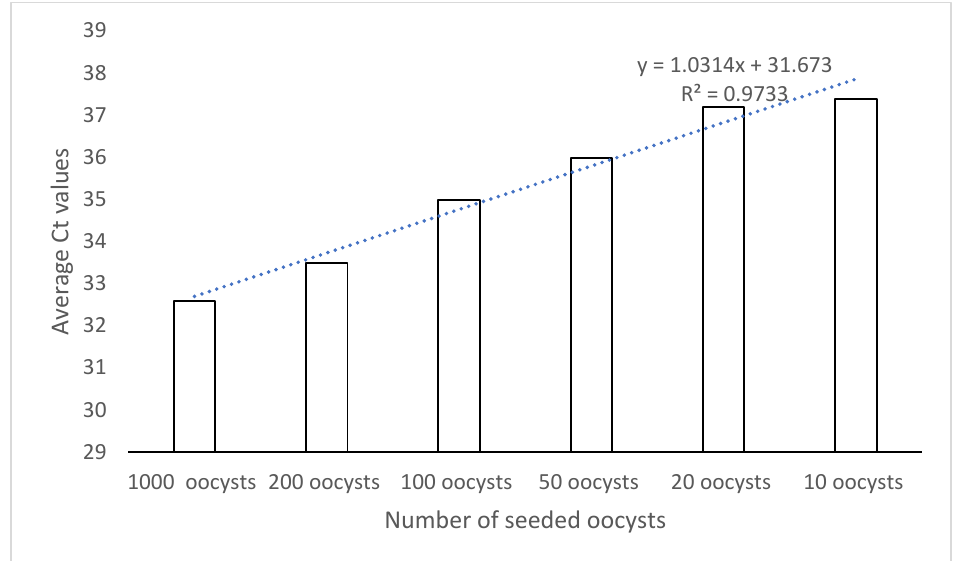
Figure 2. Linearity of C. cayetanensis detection of the flotation protocol in soil samples seeded with known numbers of oocysts.